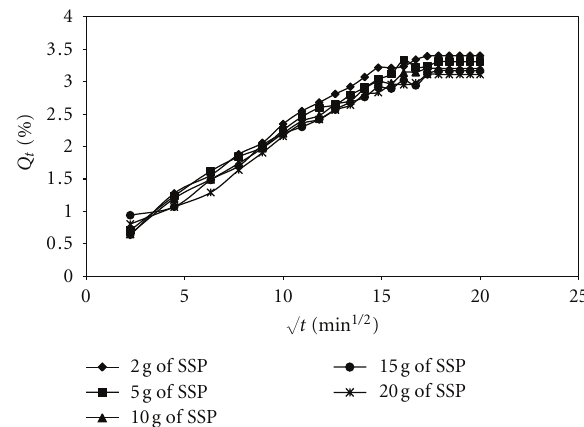
√ t (min 1 / 2 ) for snail shell powder